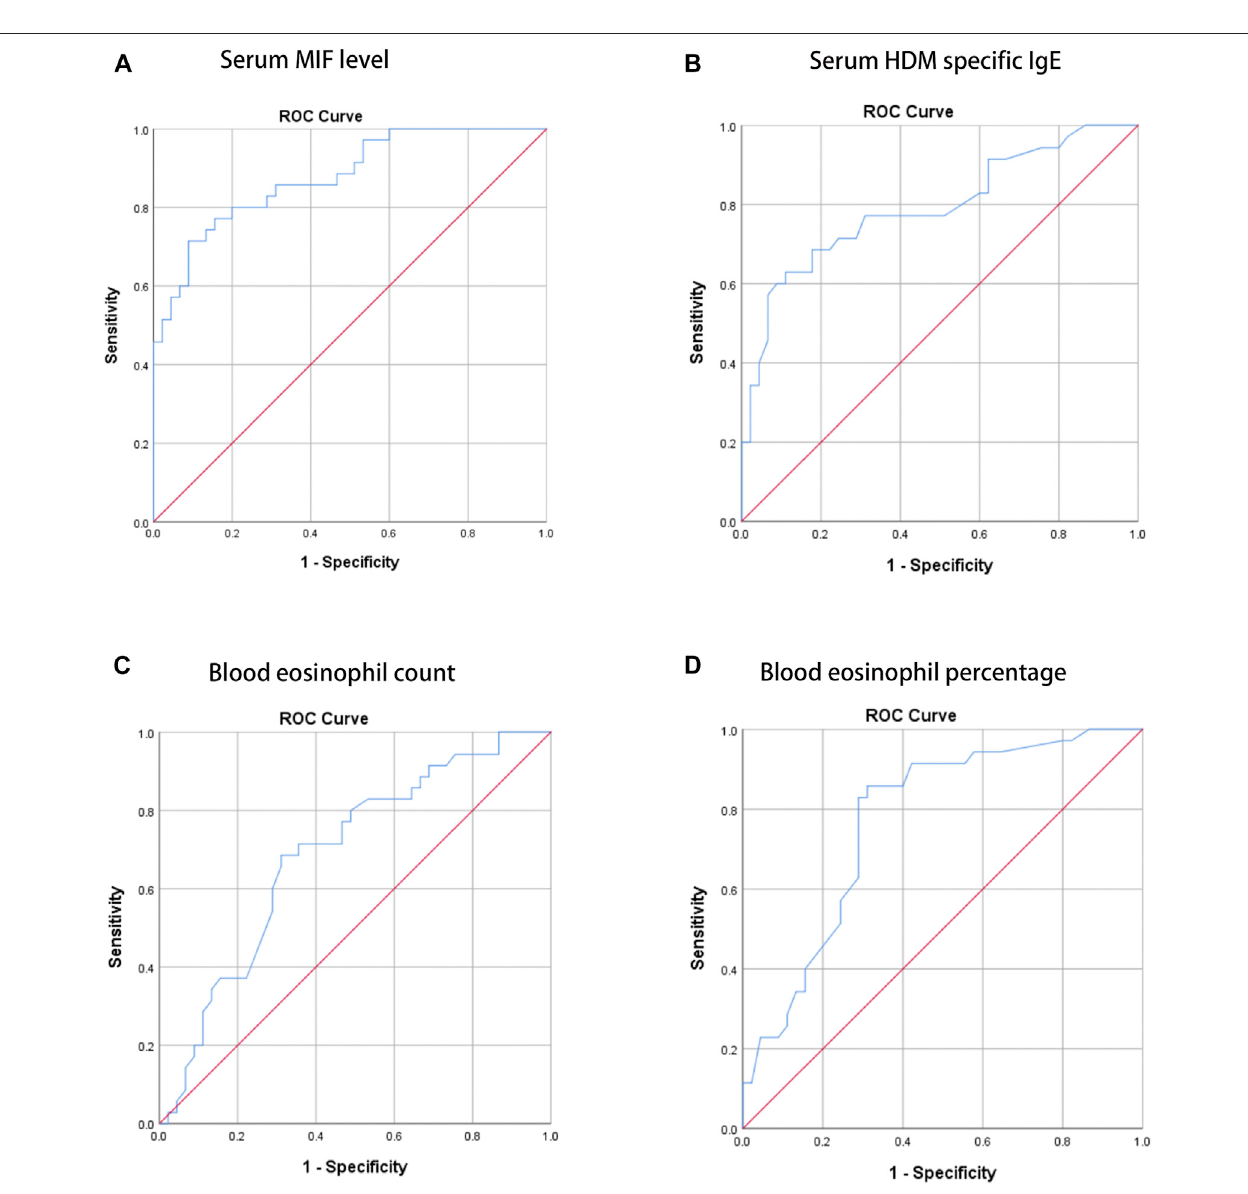
FIGURE4| ROCanalysisofserumMIF level (A) ,serum HDM – speci fi cIgE (B) ,blood eosinophilcount (C) ,and percentage (D) inpredicting theclinicalresponseof SLIT in HDM-induced AR. ROC, receiver operating characteristic; MIF, macrophage migration inhibitory factor; HDM, house dust mite; AR, allergic rhinitis; SLIT, sublingual immunotherapy.